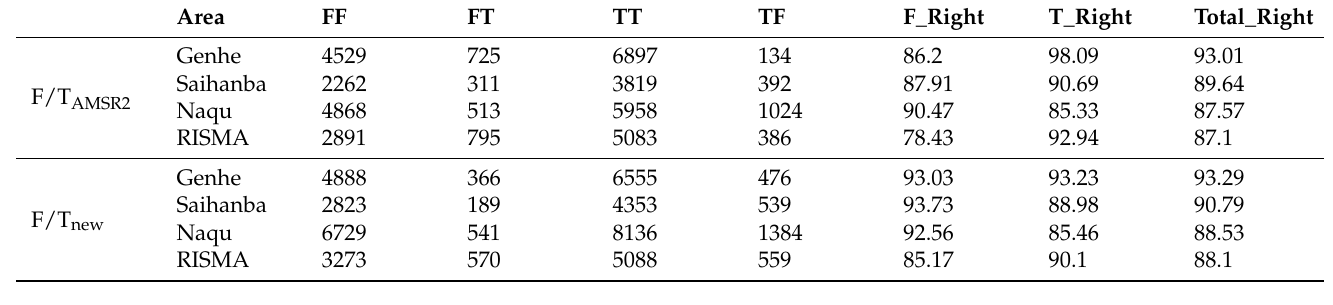
Figure 23. Frozen days calculated from the F/T new ( a ) at 1 km and F/T AMSR2 ( b ) at 25 km from June 2017 to May 2018. Table 8. Classification accuracy (%) statistics for F/T AMSR2 and F/T new .